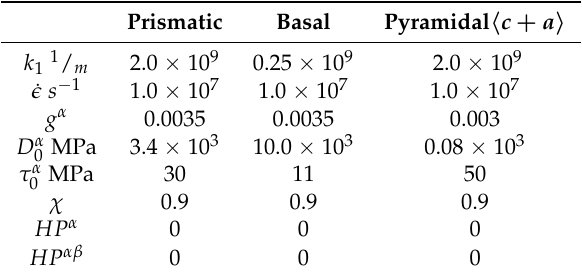
Table A1. Parameters for hardening evolution of slip.